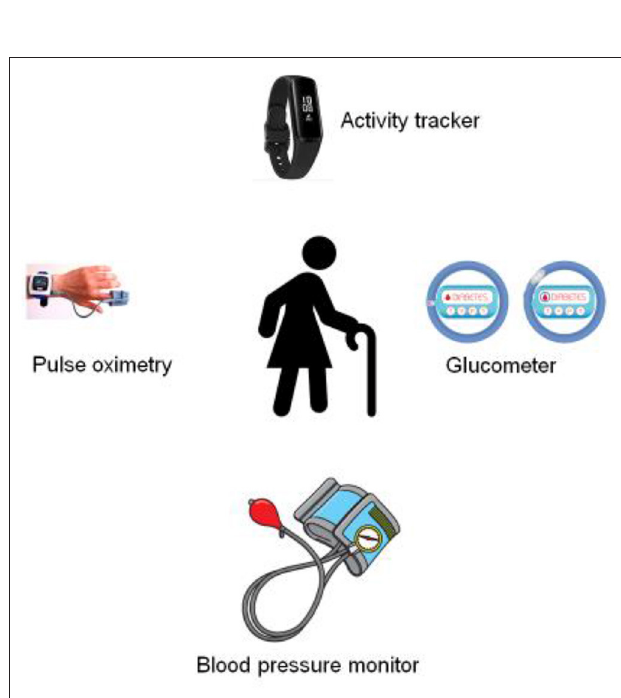
FIGURE 2 | Wearable sensor